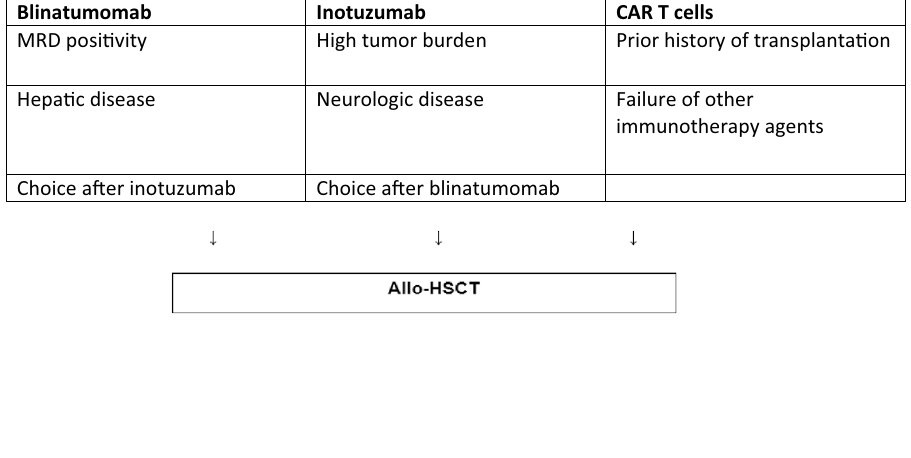
Blinatumomab Inotuzumab